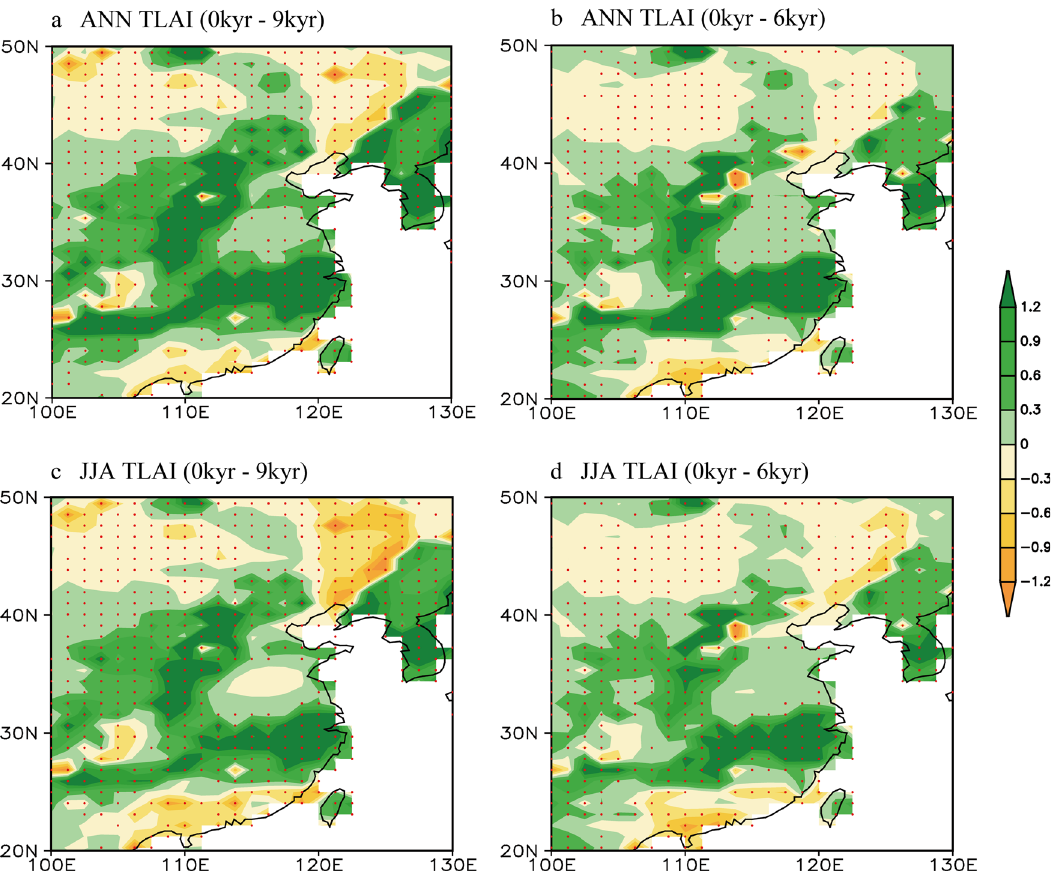
Fig. 3 Changes in total projected leaf area index (TLAI) in DV run. a , b Annual (ANN), c , d Summer (JJA). These fi gures are generated using GrADS v1.5.1.12 71